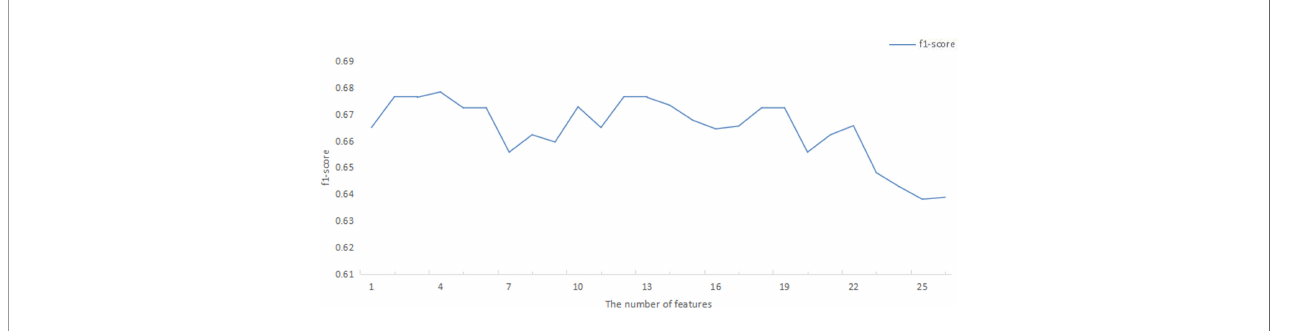
FIGURE 2 | F1_score of RF model corresponding to the number of ranked variables. RF, random forest.